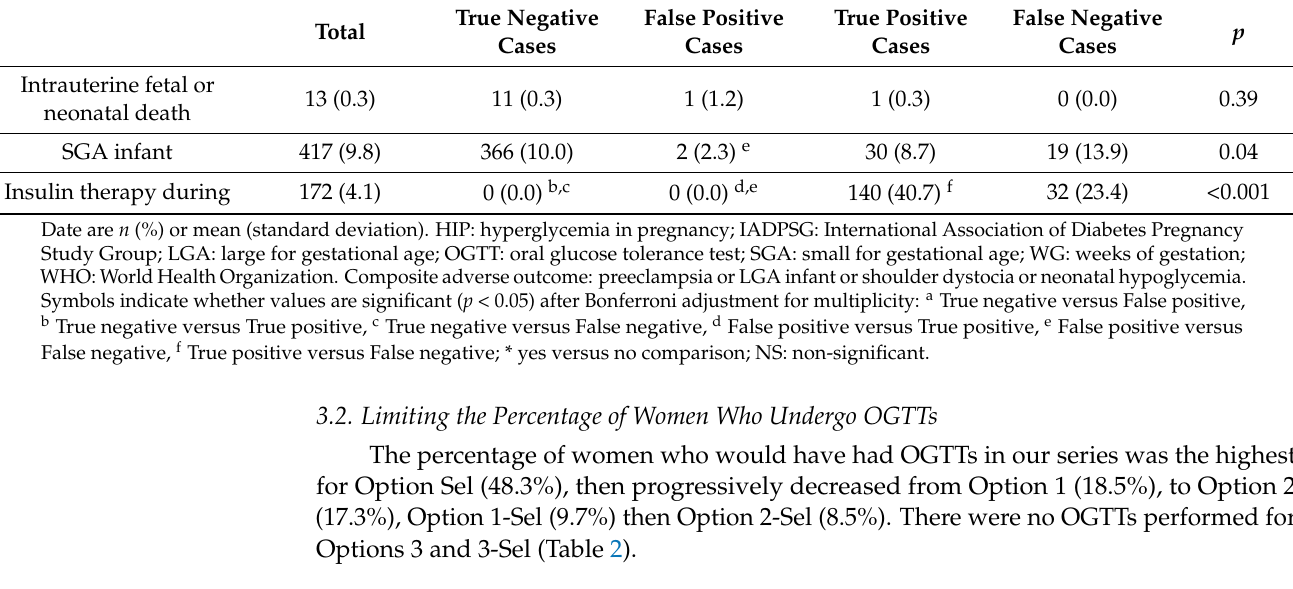
Table 2. Percentage of women who underwent oral glucose tolerance test and performance of to diagnose hyperglycemia in pregnancy, by each option.